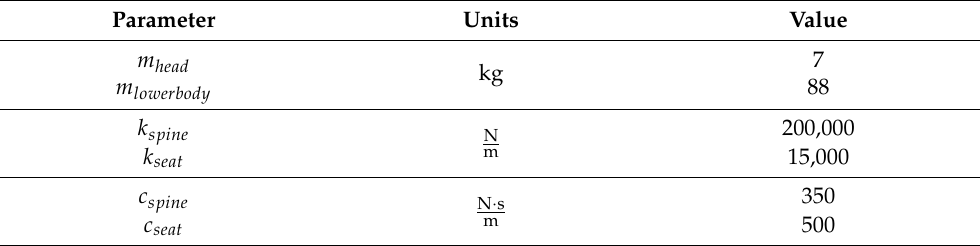
Table 4. Values of the parameters of the seat and human model in the four DOFs VSH model. Parameter